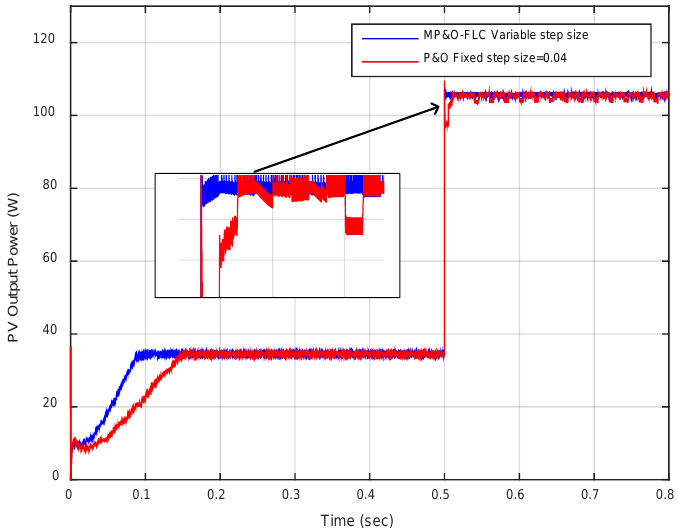
Figure 9. Comparison of PV power with fixed step size P&O MPPT and the proposed FLC-based variable step size P&O MPPT with a step change in solar irradiance.